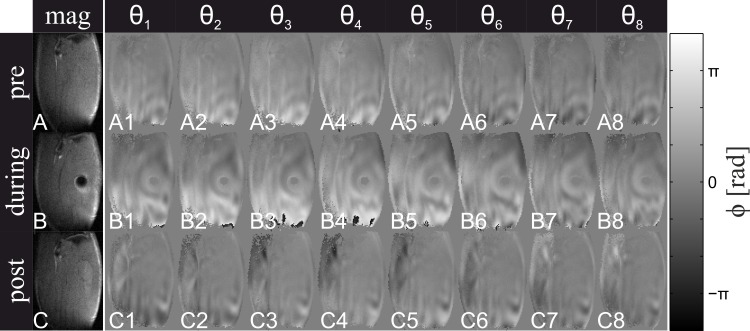
MRE pre, during post indentation.SE-MRE magnitude (mag) and wave (θ1—θ8) images before, during and after indentation. Wave images θ1, θ2, θ3, θ4, θ5, θ6, θ7, and θ8 correspond to 00, 450, 900, 1350, 1800, 2250, 2700, 3150 wave phase, respectively.